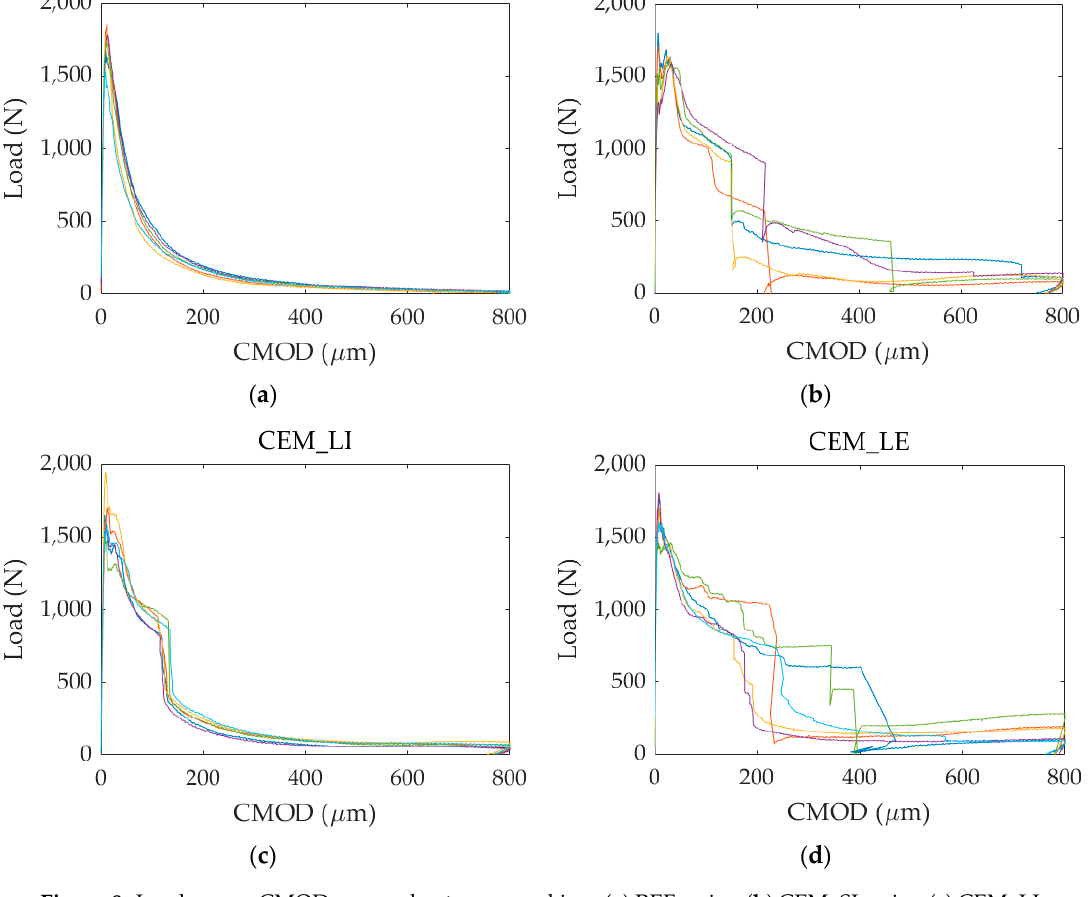
Figure 8. Load versus CMOD curves due to pre-cracking: ( a ) REF series; ( b ) CEM_SI series; ( c ) CEM_LI series; ( d ) CEM_LE series. The specimens are distinguished by different colour lines. During the controlled crack formation, first the load increased until reaching the peak value with a very low increase in terms of displacement because of the high stiffness of the intact material. After